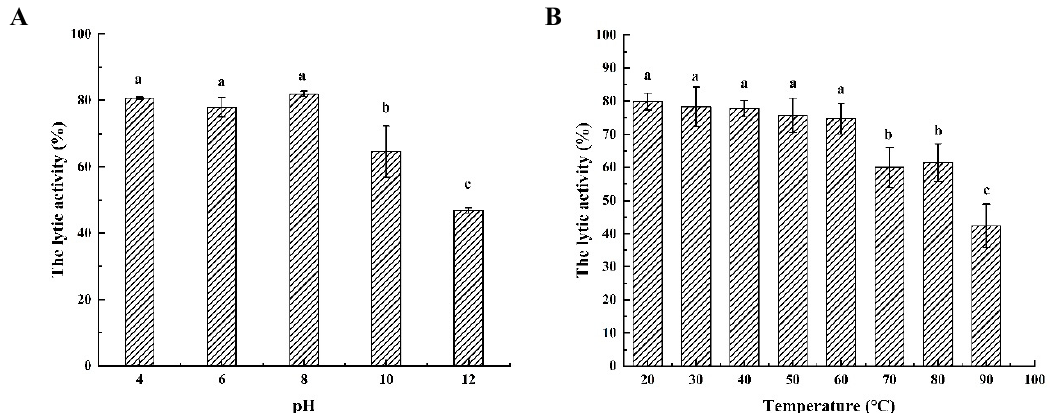
Figure 4. The stability of the endolysin LysSE24. ( A ) Temperature resistance of endolysin LysSE24. ( B ) pH dependence of endolysin LysSE24 enzymatic activity. Calculate the lytic activity by using the formula: 100% × (OD 600 nm of control − OD 600 nm of the reaction mixture with endolysins) / the initial OD 600 nm of the control. The different letters (a, b, c, and d) in the figure indicate significant differences ( p < 0.05).